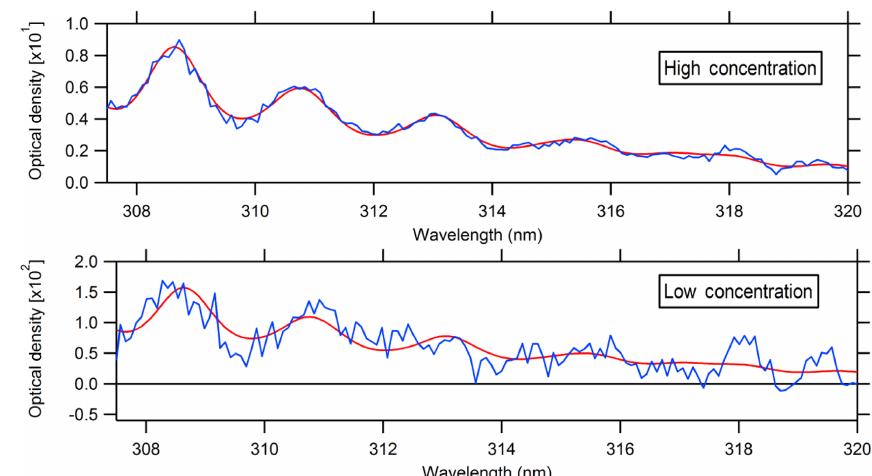
Figure 1. Examples of spectral retrievals of SO 2 from the base case (no filter and the offset function disabled) from spectra measured at a 2 ◦ viewing elevation angle using the 307.5–320nm fitting window. Retrieved dSCDs were 2.23( ± 0 . 08) × 10 17 and 4.10( ± 0 . 66) × 10 16 molec.cm − 2 for the higher and lower concentration measurements,